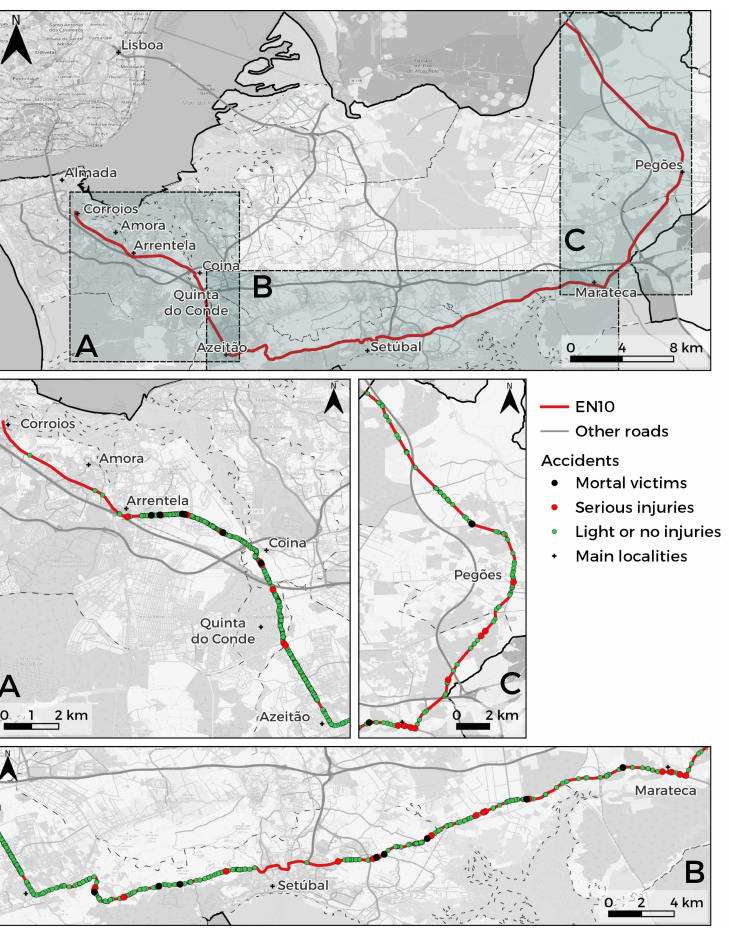
Figure 1. EN10 divided by sections, and RTA between 2016 and 2019 categorized by severity. Top: Complete EN10; Middle-left: Section A ; Middle-right: Section C ; Bottom: Section B